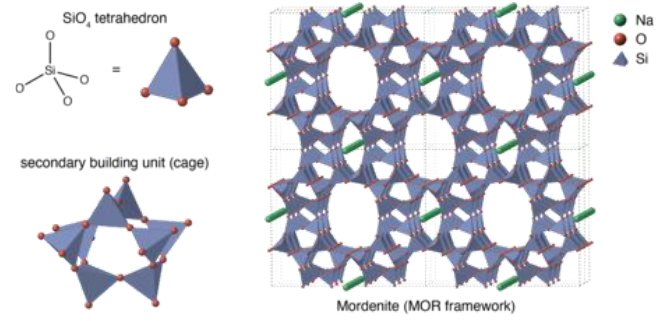
Figure 4. Chemical structure of zeolite [14,25].